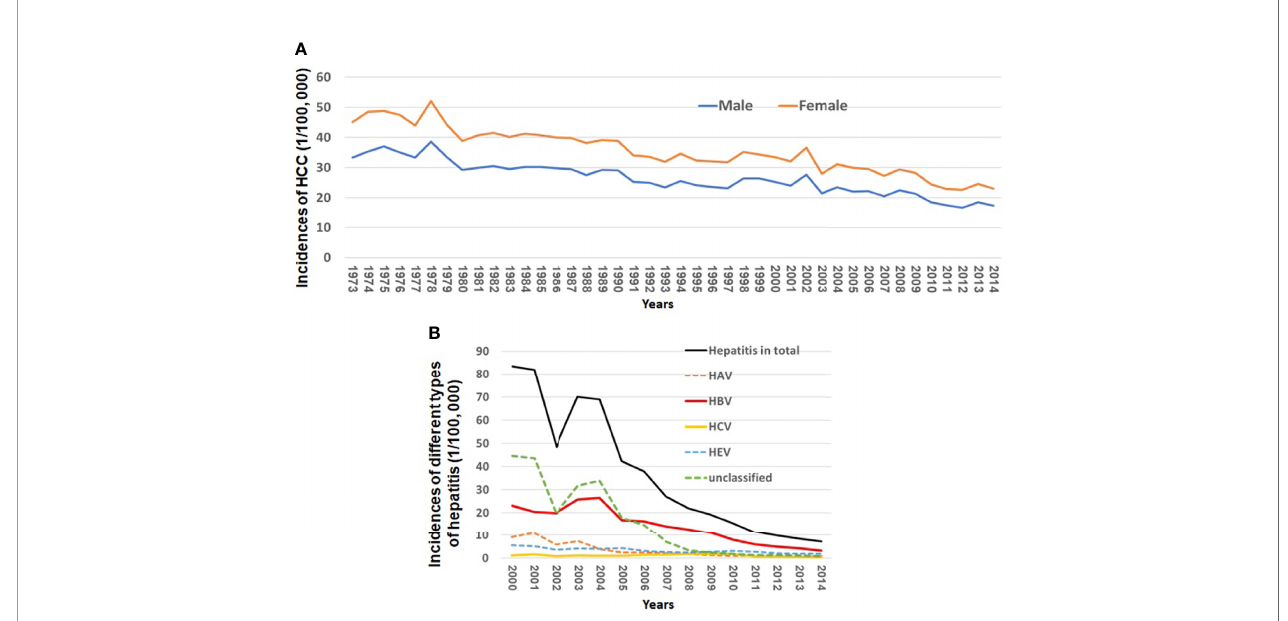
FIGURE 1 | Incidences of HCC and different types of viral hepatitis from 1973 to 2014 in Shanghai City, China. (A) Incidences of HCC from 1973 to 2014 in Shanghai City and (B) incidences of HAV, HBV, HCV, HEV, and unclassi fi ed hepatitis from 2000 to 2014 in Shanghai City.